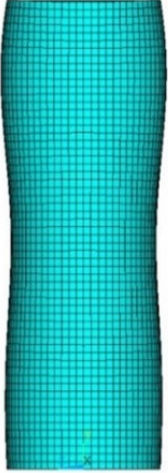
Figure 5. Magnified view of local imperfections.